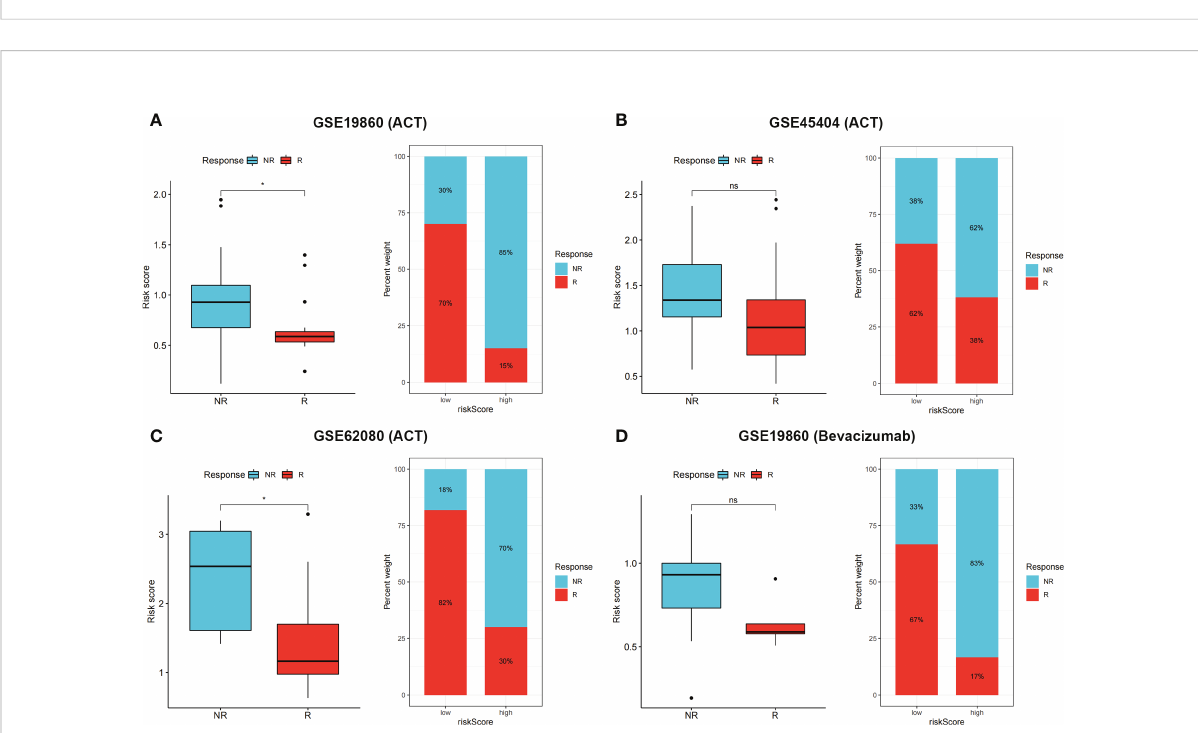
FIGURE 7 (A – D) Non-responders to 5-Fluorouracil chemotherapy and bevacizumab had higher risk score in multiple cohorts, the proportion of NR and R patients in these three cohorts was also shown. ns p > 0.05 and * p <